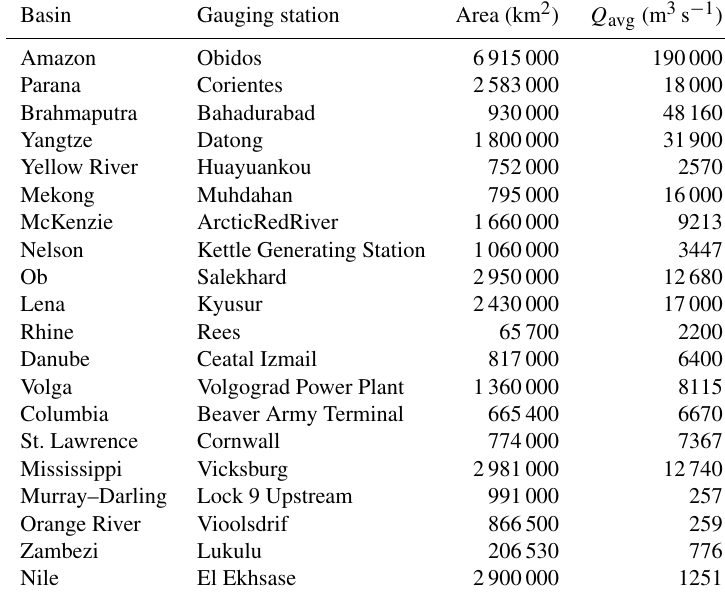
Table 1. Basin characteristics and gauging stations